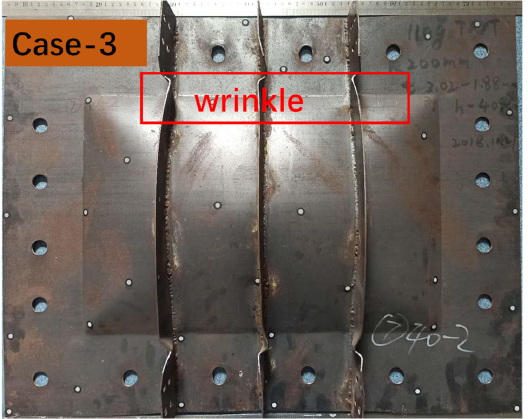
Figure 17. Failure mode of stiffened plate: Test No.